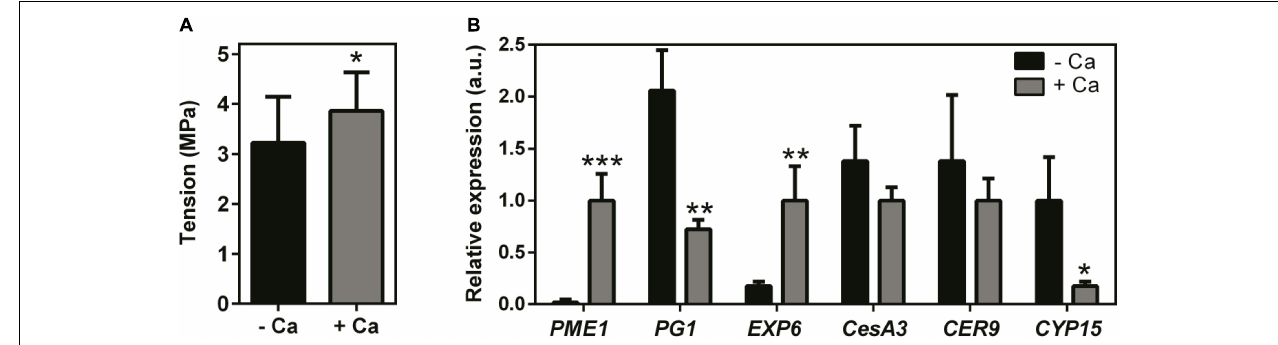
FIGURE 2 | Firmness (A) and transcript levels of genes involved in cell wall and cuticle structures (B) , in berries from vines cv. Loureiro treated with Ca (+ Ca) or without treatment (– Ca). Firmness is expressed as the tension necessary to perforate the fruit skin; n = 24. Transcript levels are shown for pectin methylesterase